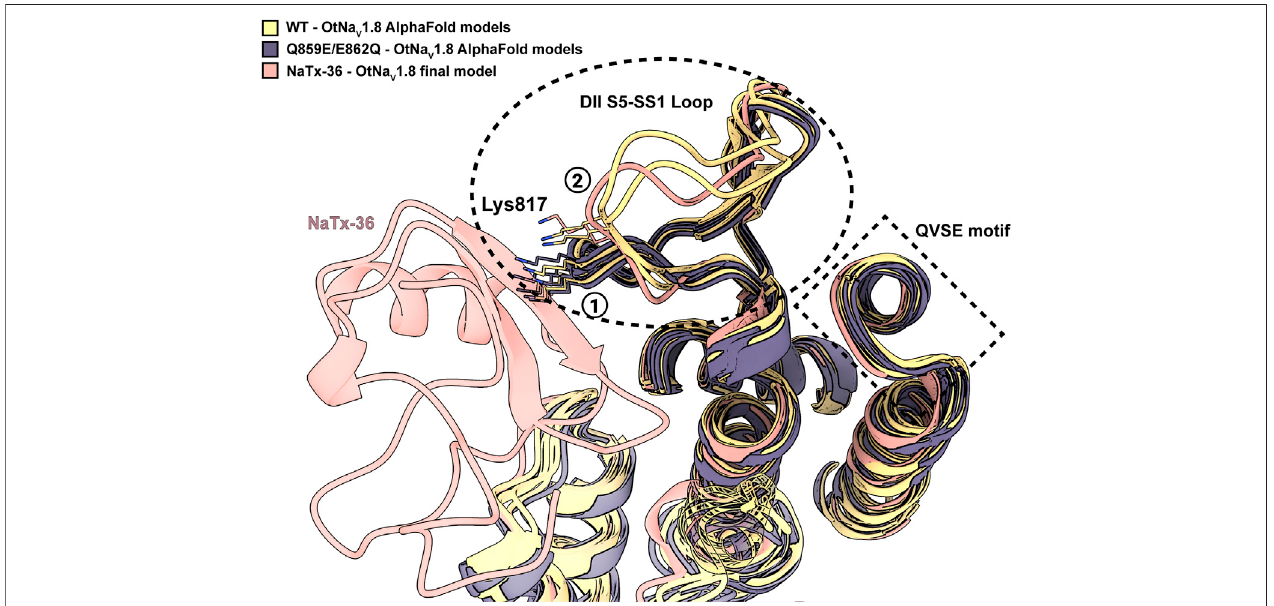
FIGURE 14 | DII S5 – SS1 loop conformations in WT-OtNa V 1.8 and mutant SS2 – S6 Q859E/E862Q – OtNa V 1.8. AlphaFold models predict two different conformationsfortheDIIS5 – SS1loopintheWTchannel(seecircled1and2);threemodelsinthe fi rstconformationandtwointhesecond(yellowmodels).Thesecond loop conformationisthe onepredicted byRosettaDock tobindNaTx36 (pinkmodel). However, thesecond loopconformation isnotpresentinthepredictedmodels for the mutant channel. In the mutant channel SS2 – S6 Q859E/E862Q – OtNa V 1.8, the DII S5 – SS1 loop was modelled by AlphaFold only in the fi rst conformation observed for the WT (black models). Interestingly, superimposed models predict a steric clash between channel residue Lys817 and NaTx36 if the DII S5 – SS1 loop occupies the fi rst conformation.